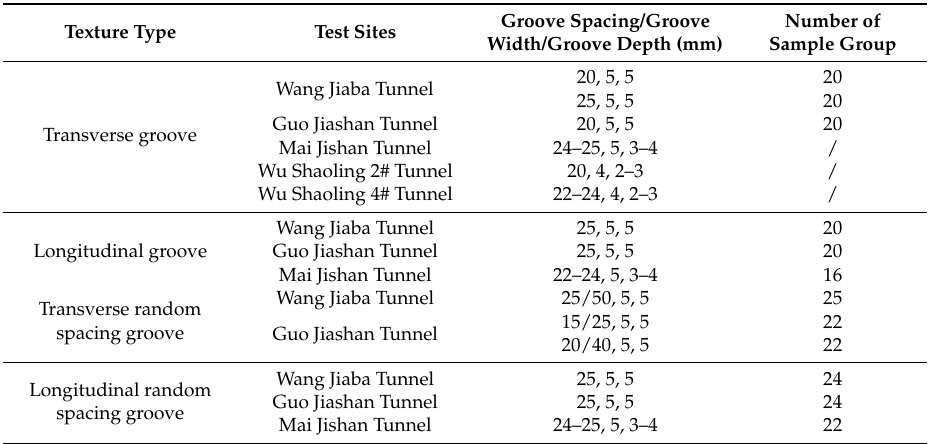
Table 1. Test section information of concrete